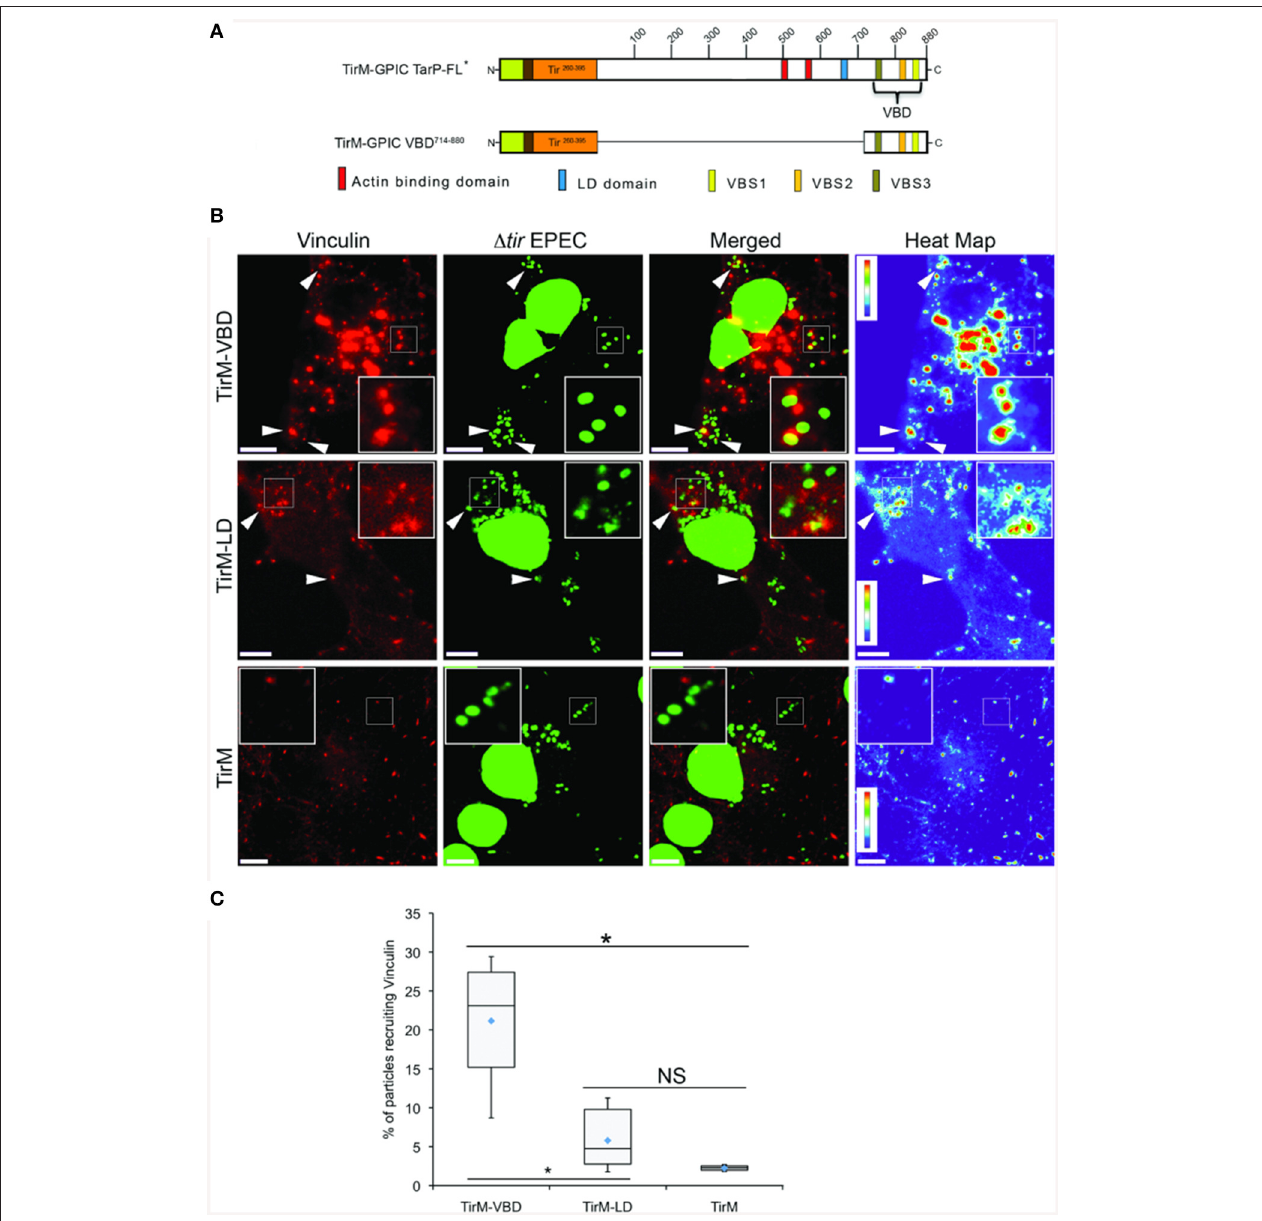
FIGURE 4 | The vinculin binding domain of TarP is functional and able to recruit vinculin. (A) Schematic of full length C. caviae TarP deleted of the proline rich domain (TarP FL * ) and the TarP Vinculin Binding Domain (VBD; TirM-VBD) indicating the locations of the N-terminal membrane targeting sequence (yellow box), Ha-tag (brown box), TirM (amino acids 260–395; orange box), actin binding domains (red box), the LD domains (blue box), Vinculin Binding Site 3 (VBS; brown box), VBS2 (light orange box), and C-terminal VBS1 (yellow box). The numbers indicate amino acid positions encoded within the C. caviae TarP gene. *Denotes TarP derivative deleted for the PRD. (B) Cos7 cells transfected with plasmids encoding the VBD (TirM-VBD), the LD domain (TirM-LD), or the TirM control were infected with 1 tir EPEC to induce clustering of the fusion protein. Transfected cells were identified by their ability to bind 1 tir EPEC. Heat map of the vinculin channel highlights the intensity of vinculin recruited to sites of bacterial adherence. The white arrowheads indicate colocalization of vinculin (red) with 1 tir EPEC (false-colored green). Vinculin was visualized with an anti-vinculin antibody. Bacteria were visualized by DAPI staining. Scale bars: 10 µ m. Heat map representation (red, high; violet, low) was generated using imageJ. (C) Adhered EPEC able to recruit vinculin were enumerated for TirM, TirM-LD and TirM_VBD, and data represented as box and whisker plot. Data compiled from three independent experiments. Plot shows range (statistical outliers excluded), first and third quartiles, and overall median (horizontal line). Diamonds show means. A range of 310–680 particles was counted. Insets show a magnification of a selected area of the cell. The asterisk and bars indicate significance difference between specific groups (One-way ANOVA, Tukey’s post-hoc test, P < 0.00001 ). NS, not significant.